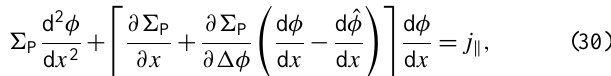
Fig. 7. Magnetospheric and ionospheric electric potential ˆ φ (black) and φ (blue, red, green), field-aligned cur- rent j (blue, red, green), and conductivity Σ (blue, red, green) for a converging electric field ( (cid:15) = 500 mV/m, P k K = 0 . 2 mA/kV = Σ = 5 S (blue) and a vari- m 2 ). The curves correspond to constant conductivity Σ + P 0 = Σ + δ Σ ∆ φ with δ Σ = 2 S/kV (red and green). The solution is computed by an able conductivity Σ 0 P approximation (red, see text) or numerically (green). For the field-aligned currents, the solid red line shows d j = K ∆ φ , while = d (Σ φ ) ; the discrepancy between both indicates the dashed red line represents j + P k k d x d x the quality of the approximation. This discrepancy is consistent with the numerical solution.